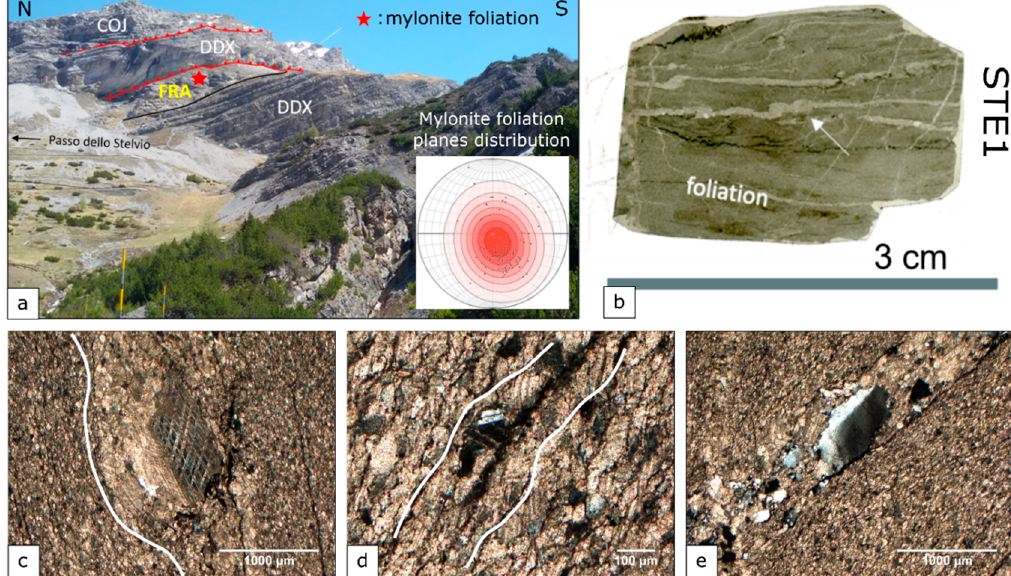
Figure 2. Meso- and microstructural features of the Austroalpine cover in the Braulio Valley. ( a ) N–S geological section through the stratigraphic succession comprising orthogneisses (COJ), medium bedded dolomite (DDX), and mylonitic finely laminated dolomite (FRA). Samples were collected in the FRA interval, where a strong preferred orientation is shown by stereographic projections. ( b ) Hand specimen cut into thin sections clearly displays drag fold and strained layers (white parts). ( c – e ) Microphotographs of the STE1 sample, showing the strong grain-size reduction that occurred during mylonite deformation. In c, large crystals are preserved within a fine-grained matrix that shows well-developed foliation.